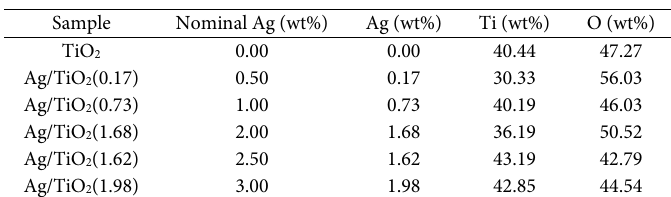
Table 2. Elemental analysis of synthesized nanoparticles obtained by EDX analysis